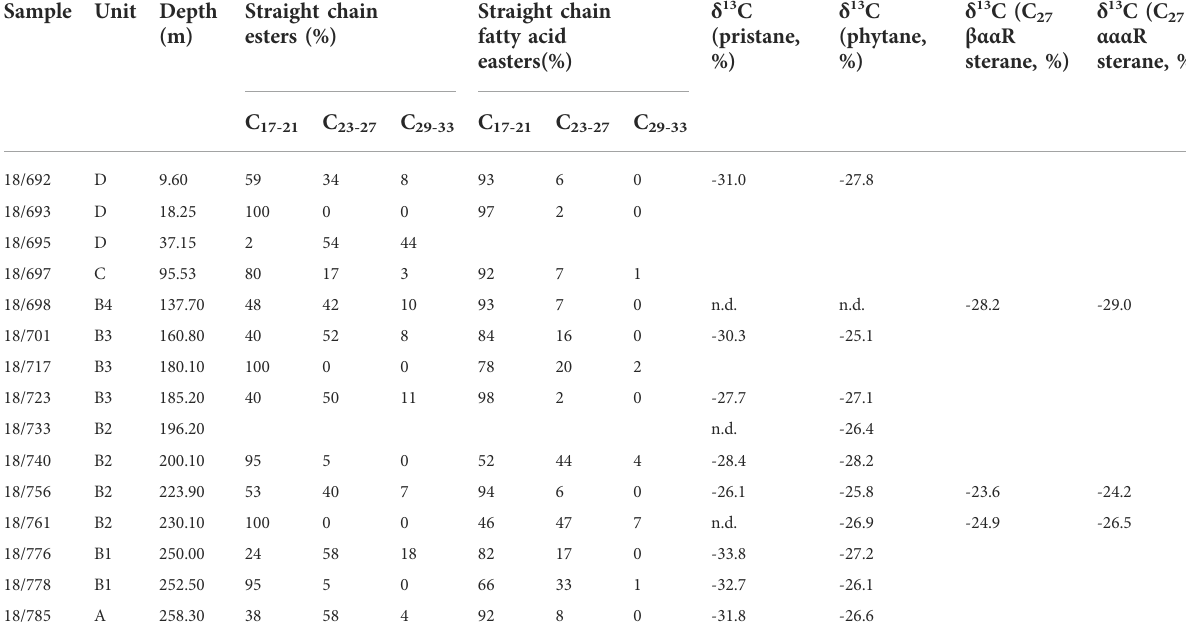
TABLE 3 Percentage of straight chain ester and alkanoic acid parameters (calculated to the sum of all esters or alkanoic acids, respectively) and compound-speci fi ccarbonisotope data ofsome speci fi cbiomarkers frompost-impactsediments in borehole NR-1973from theNördniger Ries. n.d.=not